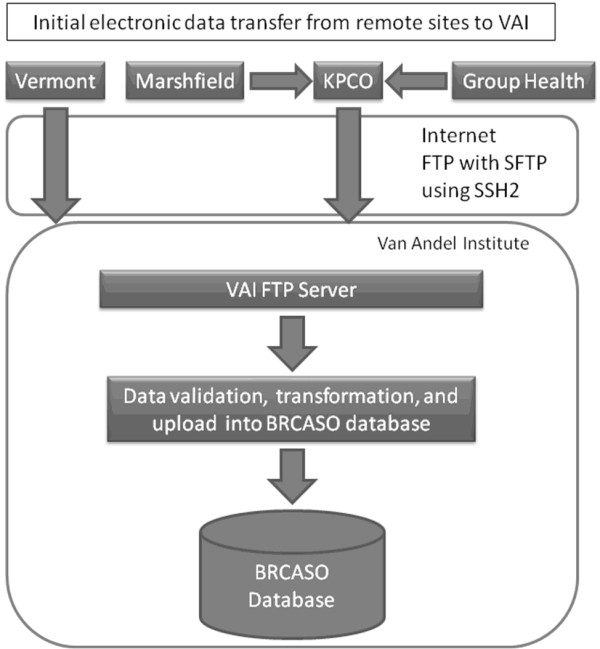
Shows how electronic data were transferred from each Cancer Research Network site (Marshfield and Group Health) to KPCO (Kaiser Permanente Colorado) before transfer to VARI (Van Andel Research Institute). Vermont transferred data directly to VARI. Data were routed through the VARI FTP (File Transfer Protocol) server and underwent initial validation before transfer to the BRCASO database.